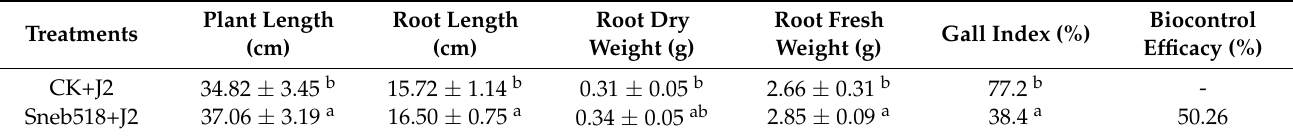
Table 4. The biocontrol effect of Sneb518 against M. incognita in the pot experiments.